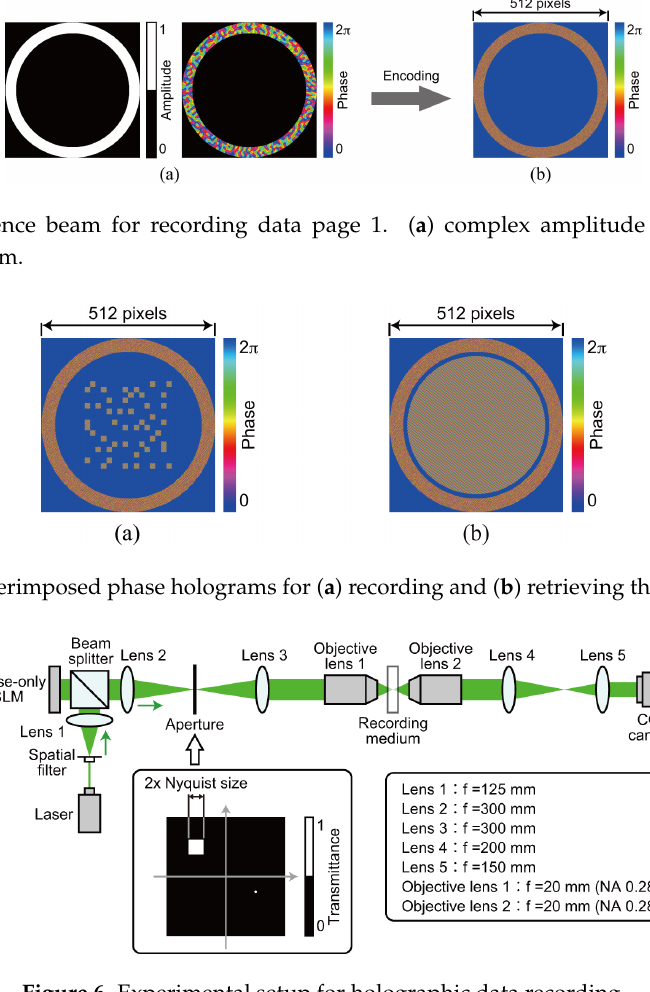
Figure 6. Experimental setup for holographic data recording.